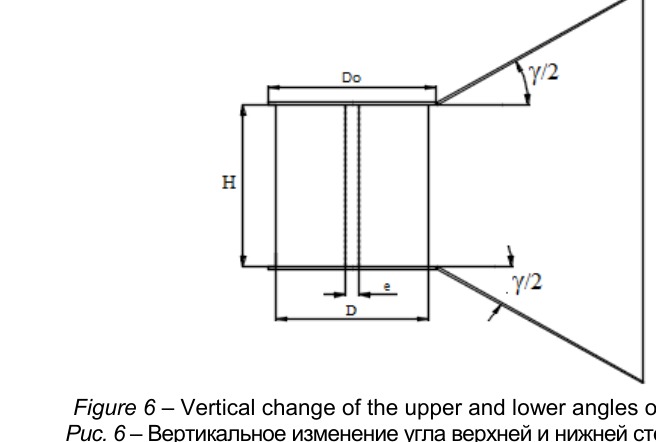
Figure 6 – Vertical change of the upper and lower angles of the wind inlet Рис . 6 – Вертикальное изменение угла верхней и нижней стенки